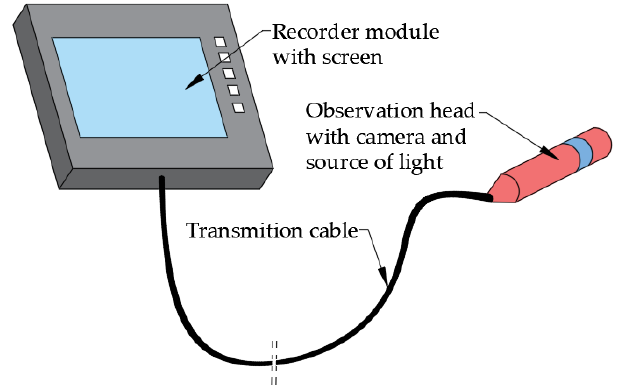
Figure 4. Scheme of the borehole camera system.